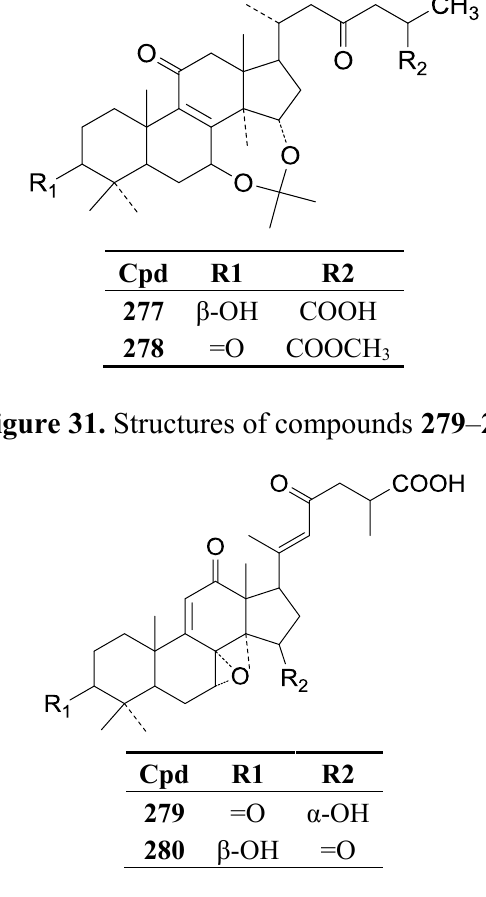
Table 11. Ganoderma triterpenes 281 – 287 , 288 – 307 , 308 – 311 , 312 , 313 – 315 , 316 in Figures